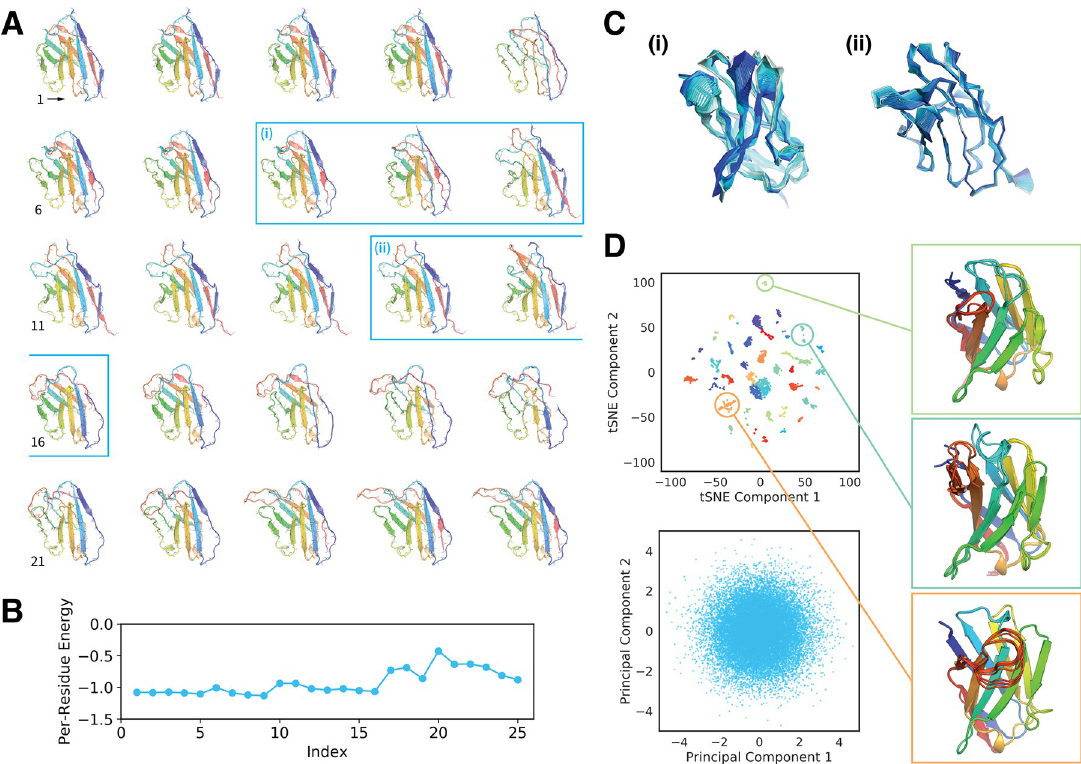
Fig 4. Latent Space Analysis and Interpolation. (A) Linear interpolation between two randomly selected embeddings. The starting and ending structures are 1TQB(H) and 5JW4(H) respectively. The backbones are unaltered, full-atom model outputs. Structures are colored by residue index in reverse rainbow order. (B) Centroid energy profiles of the structures from panel A after constrained refinement. (C) Higher frequency overlays of 80 sequential structures in the unrefined interpolation trajectory. The roman numerals correspond to the blue labels in panel A. A lighter shade of blue indicates an earlier structure while the darker shade indicates a later structure. Structure transitions are smooth and follow a near-continuous trajectory. (D) The top panel shows a tSNE dimensionality reduction of the embedding means of the 4154 non-redundant structures in the training set. Colorings correspond to k-means clusters (k = 40) of the post-tSNE data, and ten structures from three clusters are visualized to the right. The bottom panel depicts a principal components reduction of the latent space, showing five sampled data points per non-redundant